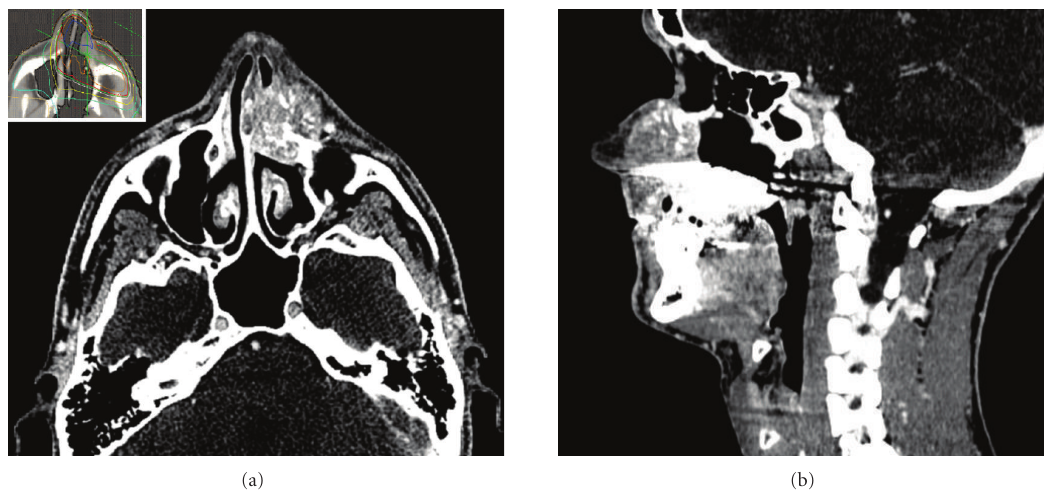
Figure 1: CT scan showing a contrast-enhanced lesion with central sunburst pattern and calcifications black asterisk (upper (axial view), lower (sagittal view)) was noted in the para-nasal and cheek soft-tissues. It extended medially into the surrounding nasal bone structures and posteriorly into the left maxillary sinus and nasal fossa. It extended superiorly to palatine prosthesis black square. Insert on Figure 1(a) shows conformational radiotherapy plan (according to Euro-Ewing 99 recommendations). Initial tumor volume was treated with a 2 cm margin and included posttherapeutic scar tissue area white asterisk.